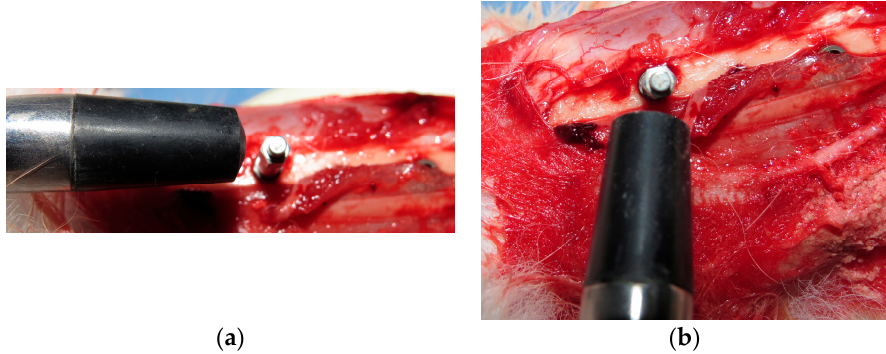
Figure 6. Implant stability measurement in two directions: ( a ) Proximo-distal and ( b ) in antero-posterior.